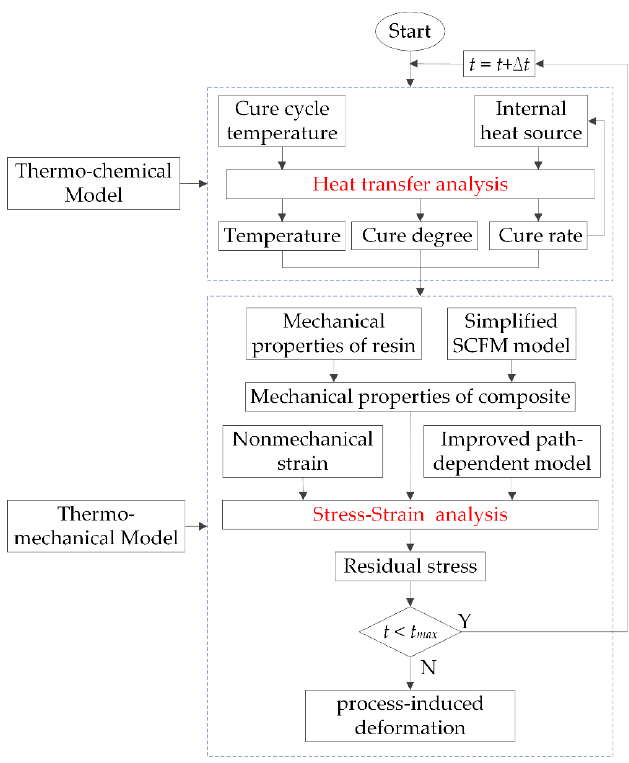
Figure 3. Simulation calculation process of numerical model.